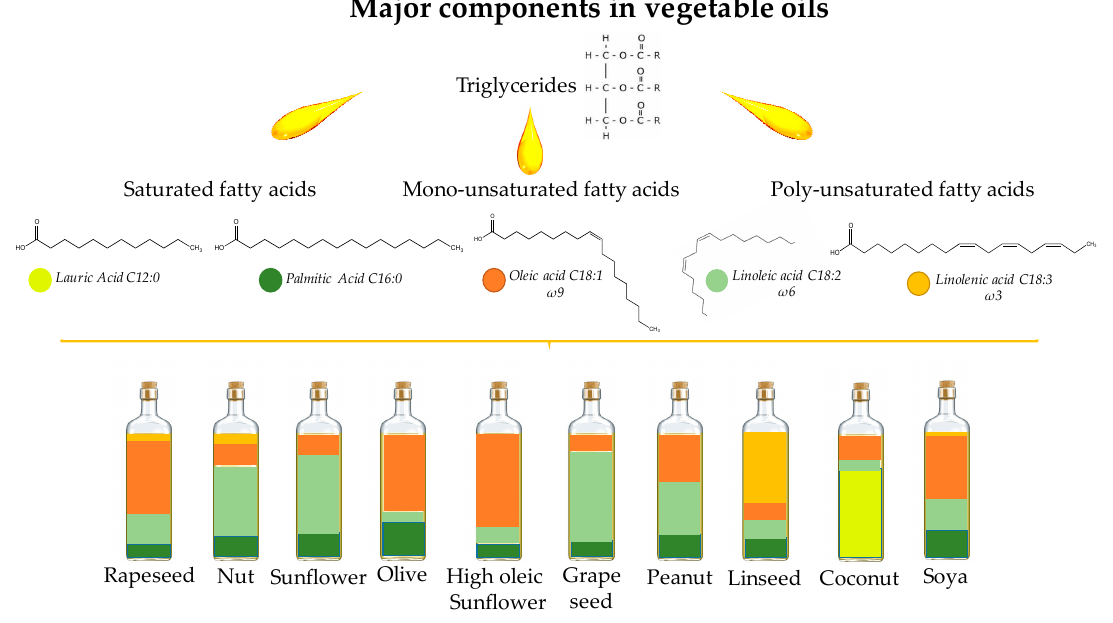
Figure 1. Major components in different vegetable oils.